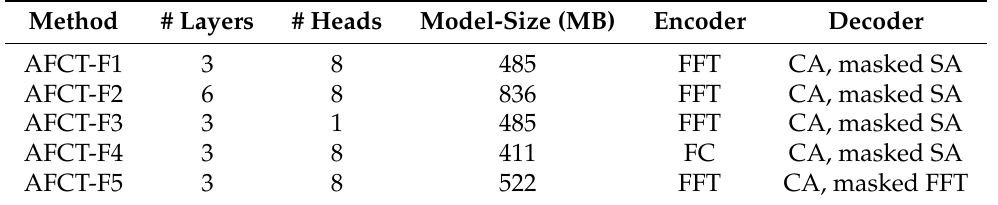
Table 2. Model configuration for the variants used in the ablation studies. Abbreviations: CA = cross- attention; SA = self-attention; FFT = fast Fourier transform; and FC = fully connected.